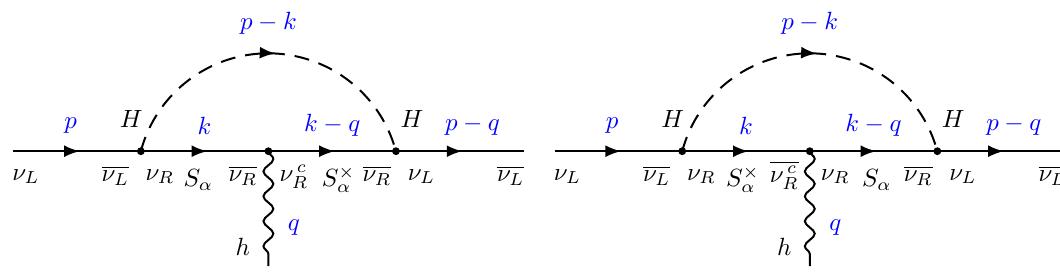
Figure 7 . One-loop self-energy diagrams with an h insertion on the sterile neutrino